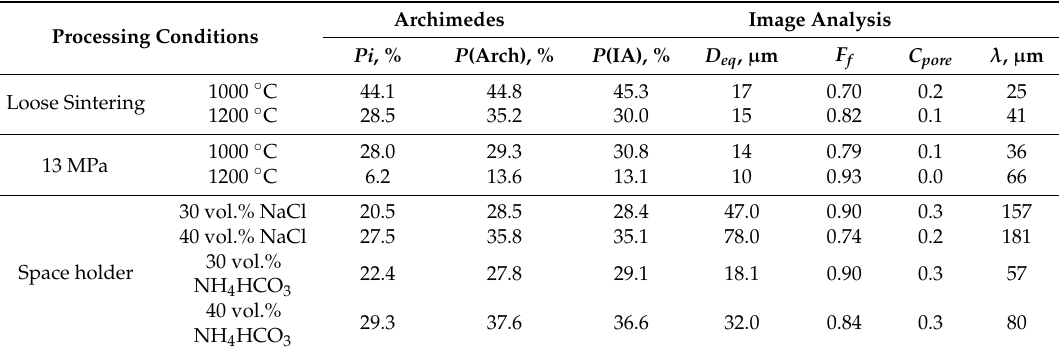
Table 2. Effect of different techniques and processing conditions on the porosity of the samples.